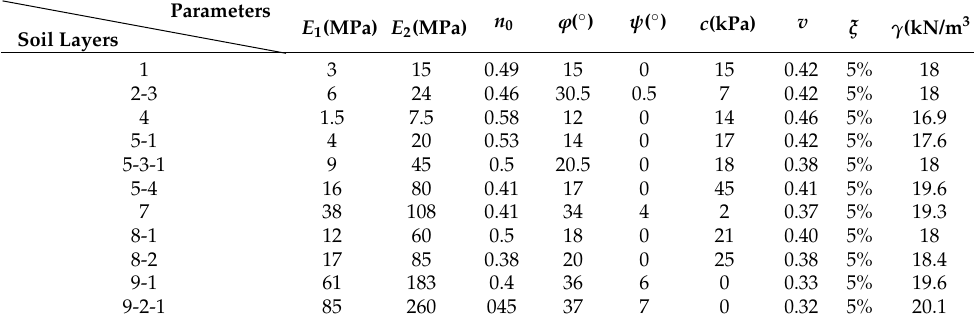
Table 1. Constitutive parameters used in the finite-element analysis in Midas/GTS. Soil